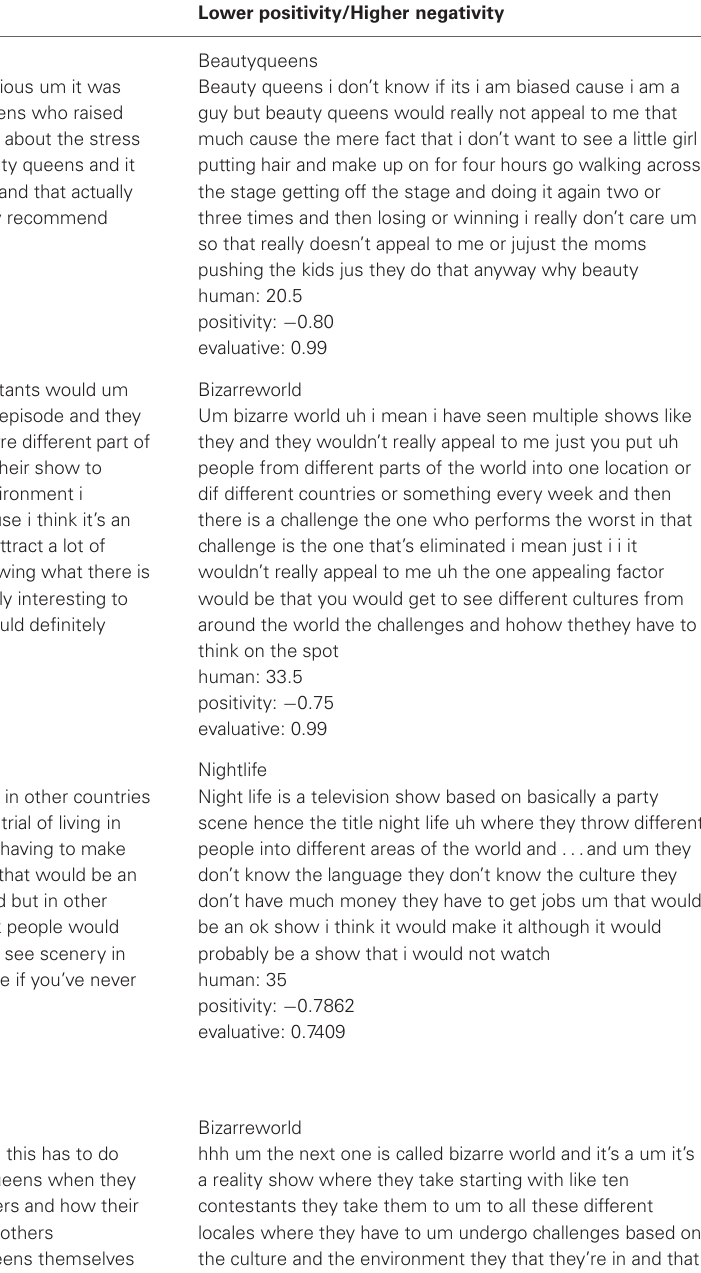
Table 1 | Example normalized text (case and punctuation removed) with associated ratings by humans who had access to full voice and visual cues (scale = 0–100), automated positivity scores from the language classifier (scale = − 1 to 1), and automated evaluative language scores from the language classifier (scale =